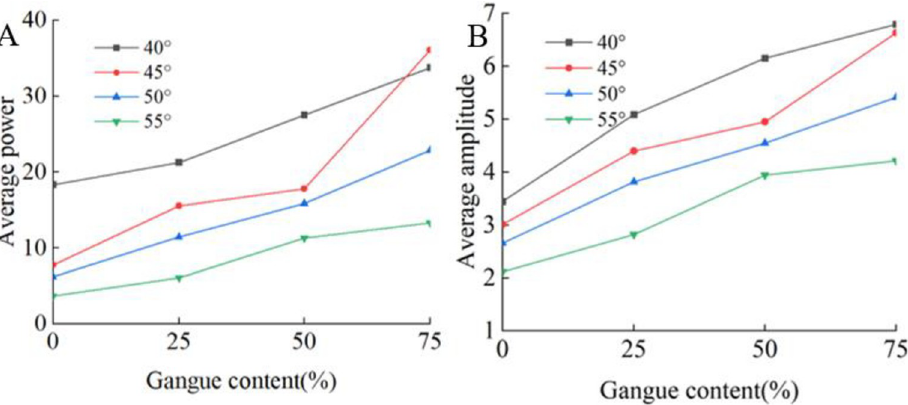
Fig 26. Relationship between gangue content and frequency domain characteristics. (A) Gangue content versus average power under the tail beam angle of 40˚,45˚,50˚,55˚. (B) Gangue content versus average amplitude under the tail beam angle of